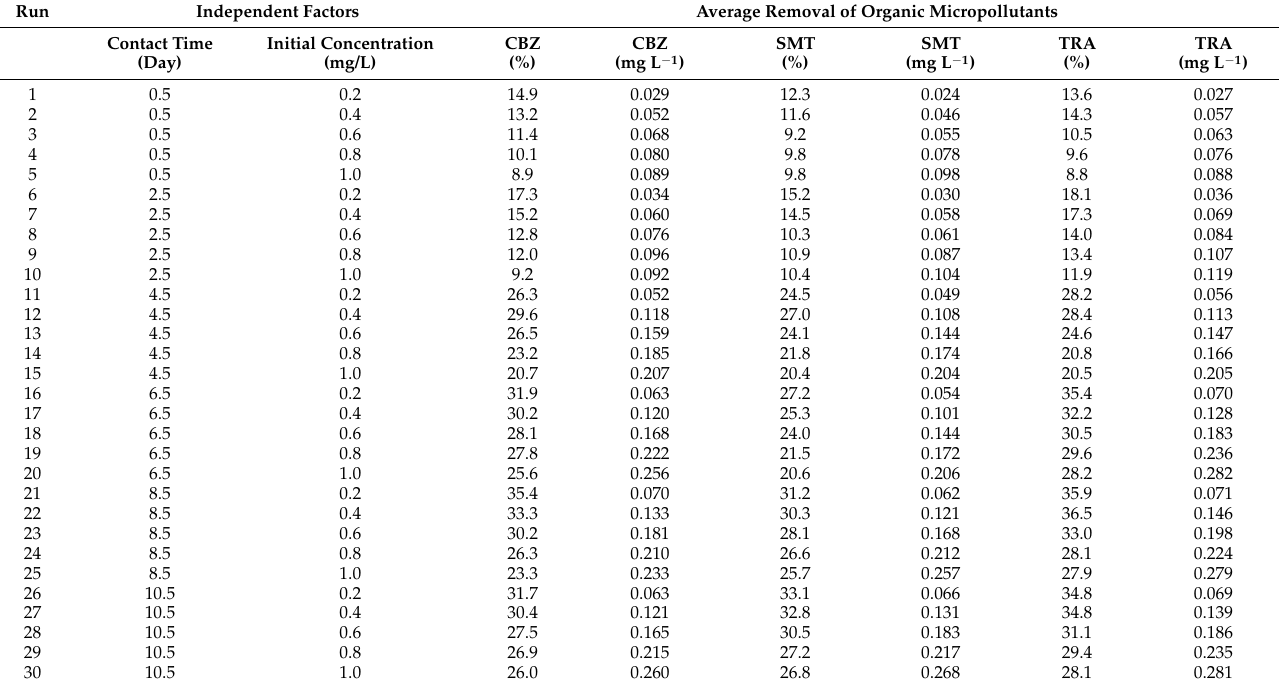
Table 2. Response values for different independent factors in the first